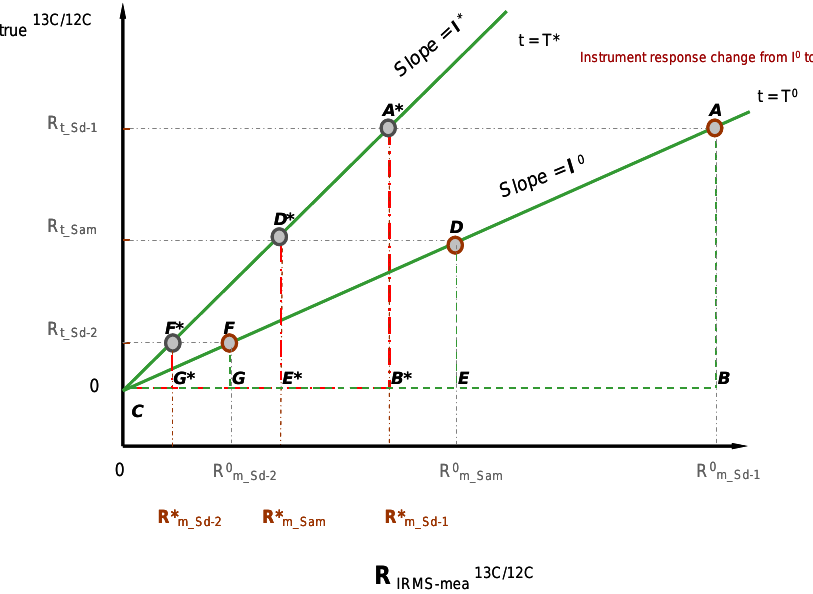
Figure 5. Schematic of the relationship between the intrinsic/ or true isotopic ratio (i.e., 929 Fig. 5. Schematic of the relationship between the intrinsic/true isotopic ratio (i.e., R = 13 C/ 12 C) and the isotopic ratio measured by IRMS. R= 13 C/ 12 C) and the isotopic ratio measured by IRMS. There are two standards (Std-1 & Std-930 There are two standards (Std-1 and Std-2) and one sample shown in the diagram. Their intrinsic/true isotopic compositions are distinguishable as R t Sd-1 , R t Sd-2 , and R t Sam on the y-axis and the corresponding measured isotopic compositions are shown on the x-axis. If the instrument 2) and one sample shown in the diagram. Their intrinsic/ or true isotopic compositions are 931 response changes from I 0 (at t = T 0 ) to I ∗ (at t = T ∗ ), the measured isotopic ratios for two standards and the sample would change from distinguishable as R t_Sd-1 , R t_Sd-2 , & R t_Sam on the y axis and the corresponding measured 932 R 0 , R 0 , R 0 to R ∗ , R ∗ , R ∗ . However, the ratios (i.e., [ R 0 / R 0 ], [ R 0 / R 0 ]) would not change m Sd-1 m Sd-2 m Sam m Sd-1 m Sd-2 m Sam m Sam m Sd-1 m Sd-2 m Sd-1 and they are always equal to the corresponding intrinsic/true ratios [ R t Sam /R t Sd-1 ], [ R t Sd-2 /R t Sd-1 ], respectively, since triangle ABC is isotopic compositions are shown on the x axis. If the instrument response changes from I 0 (at 933 similar to triangles DEC and FGC , and triangle A ∗ B ∗ C is similar to triangle D ∗ E ∗ C and F ∗ G ∗ C , as illustrated in the above t = T 0 ) to I * (at t = T * ), the measured isotopic ratios for two standards and the sample would 934 change from R 0 m_Sd-1 , R 0 m_Sd-2 , R 0 m_Sam to R * m_Sd-1 , R * m_Sd-2 , R * m_Sam . However, the ratios 935 (i.e., [R 0 m_Sam / R 0 m_Sd-1 ], [R 0 m_Sd-2 / R 0 m_Sd-1 ]) would not change and they are always equal to 936 the corresponding intrinsic/true ratios [R t_Sam / R t_Sd-1 ], [R t_Sd-2 / R t_Sd-1 ]), respectively, since 937 triangle ABC is similar to triangles DEC and FGC , and triangle A*B*C is similar to triangle 938